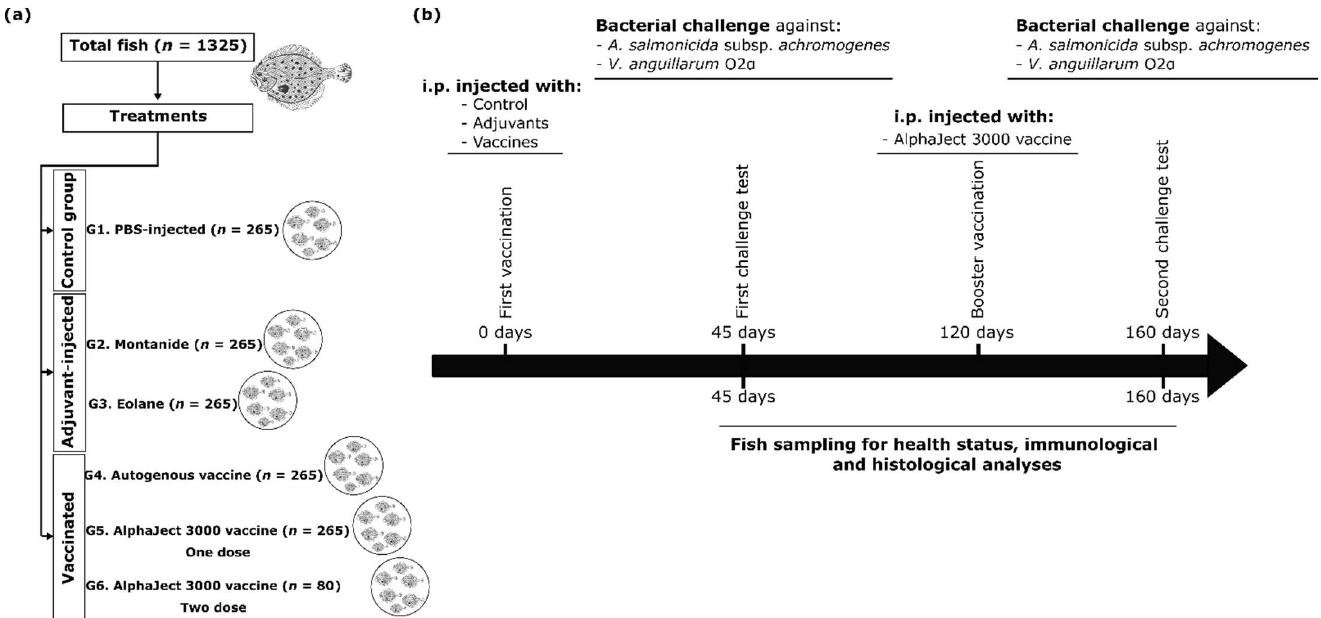
Figure 1. Experimental design ( a ), vaccination strategy, and sampling procedures ( b ).